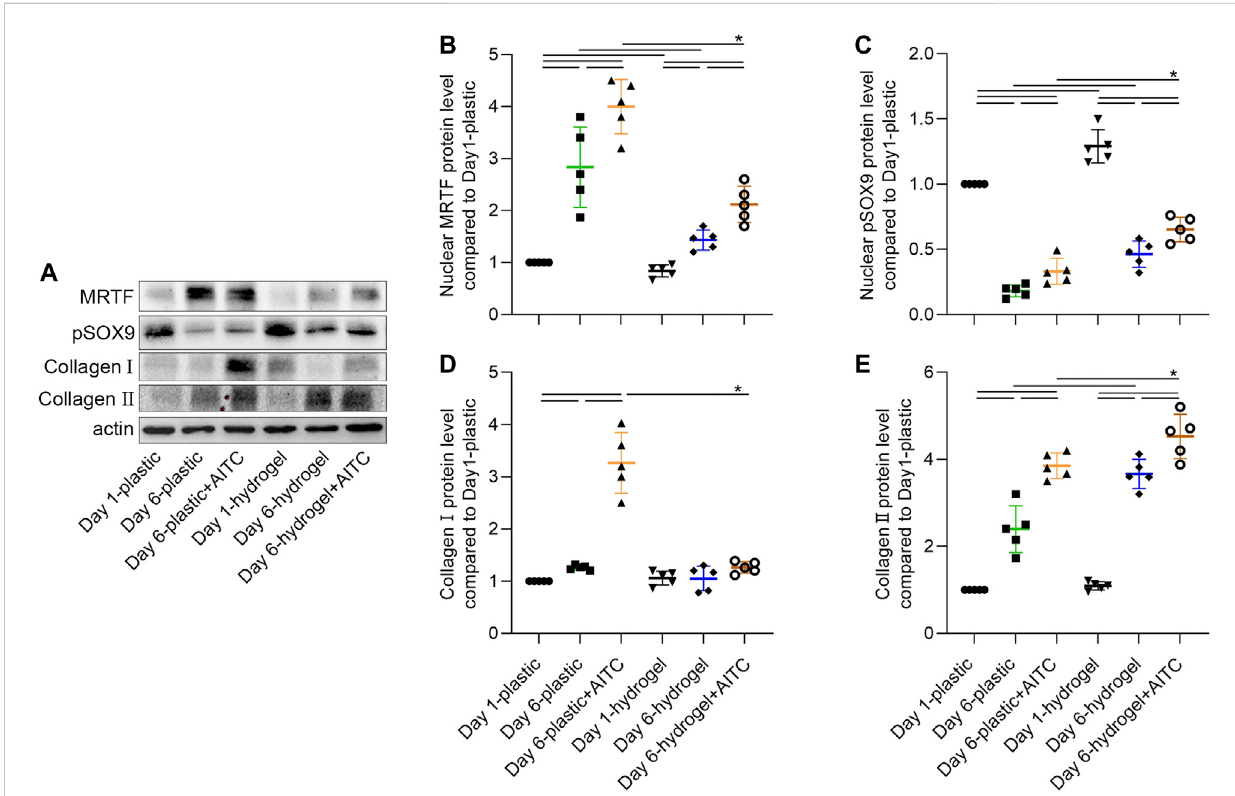
WB analysis of nuclear MRTF-A, pSOX9, and collagen Ⅰ / Ⅱ expression. CHs were divided into two groups, one was cultured on plastic and the other was cultured on hydrogel. Each group was then sub-grouped into three: 1-day culture, 6-day culture, and 6-day culture with AITC treatment. (A) Representative images of the blots of each target, and the quantitative analysis of (B) nuclear MRTF-A, (C) nuclear pSOX9, and (D) collagen Ⅰ and (E) collagen Ⅱ expression. Results are expressed using the boxplots ( n = 5 samples). Repeated measures ANOVA followed by Dunnett ’ s post-test was used in the statistical analysis. The differences are considered statistically signi fi cant at p < 0.05. (P: plastic, G: